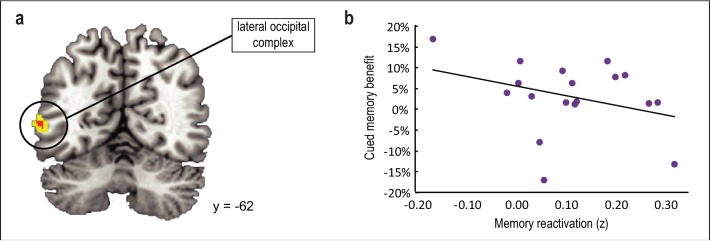
Main effect of odor cueing on category reactivation.(a) Odor cues evoked reactivation of associated category templates in lateral occipital complex ([−56,–62, 4], t(16) = 3.99, punc = 0.001), although this effect did not survive statistical correction for multiple comparisons. (b) The degree of reactivation in this cluster was not predictive of memory enhancement for cued versus noncued categories upon waking (r(16) = −0.33, p = 0.19). fMRI activity is shown at p < 0.001 uncorrected (red) and p < .005 uncorrected (yellow), and images are overlaid on a canonical single-subject T1-weighted MRI scan.10.7554/eLife.39681.028Figure 5—source data 1.Relates to panel (b).